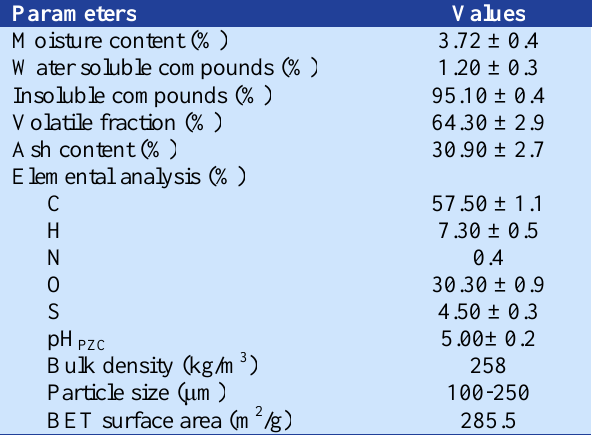
Table 2. Several physichochemical characteristics